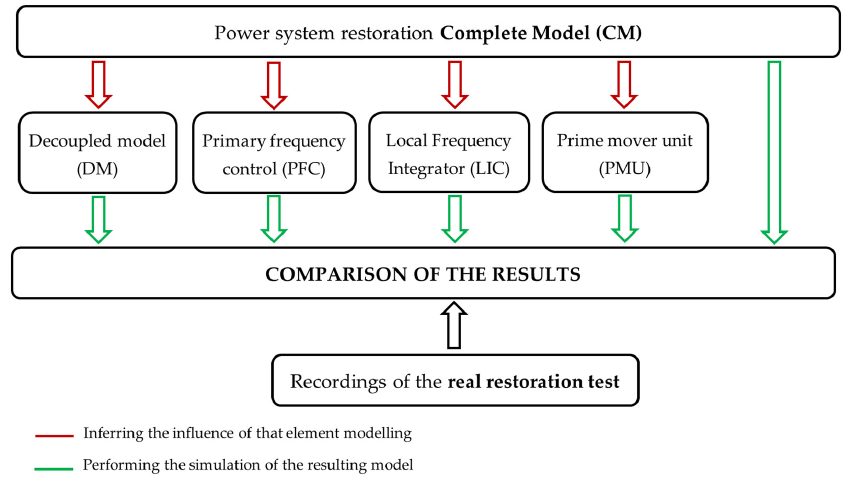
Figure 1. Visual scheme of the studies performed in this paper.